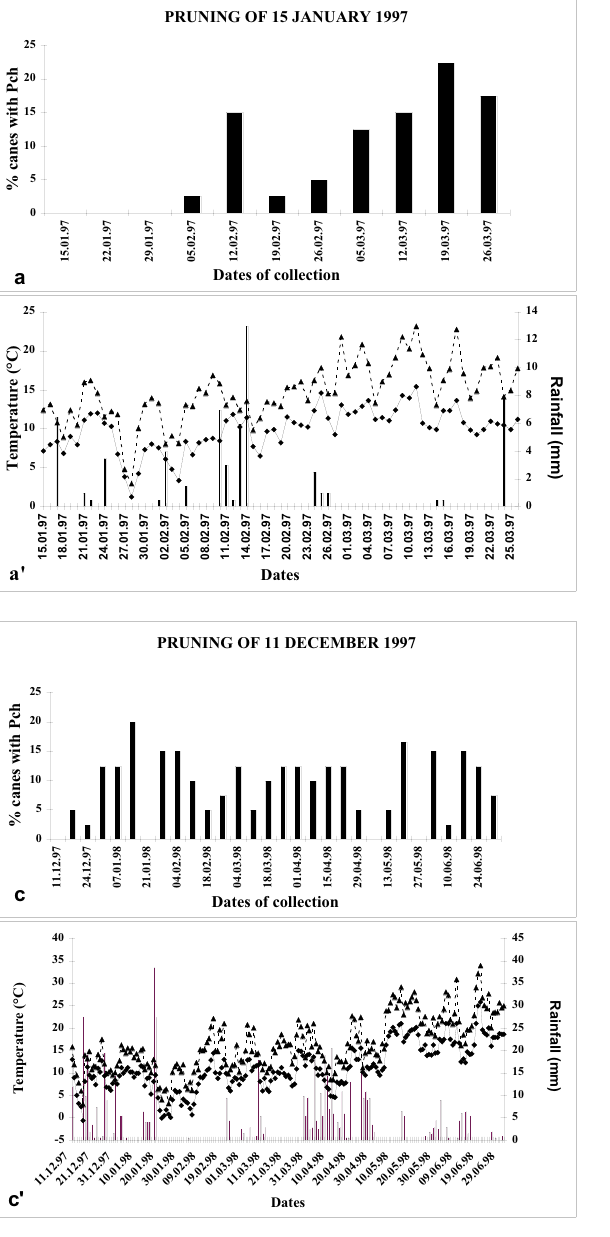
Fig. 1. Comparison of the periods of contamination of pruning wounds by Phaeoacremonium chlamydosporum (a, b, c, d) in relation to climatic data (a’, b’, c’, d’) at two pruning dates in winter 96-97 and in winter 97-98. Daily mean temperature (line), daily maximum temperature (dotted line) and daily rainfall